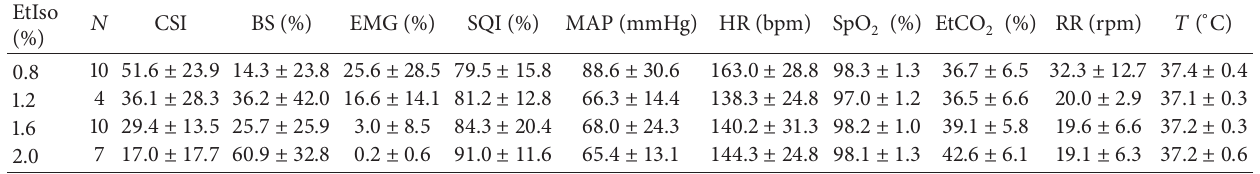
Table 1: Electroencephalographic parameters derived by the CSM and other physiologic data recorded at each end-tidal isoflurane concentration (EtIso—%) studied. The number of animals ( 𝑁 ) at each EtIso step is shown. Mean ± standard deviation is shown.